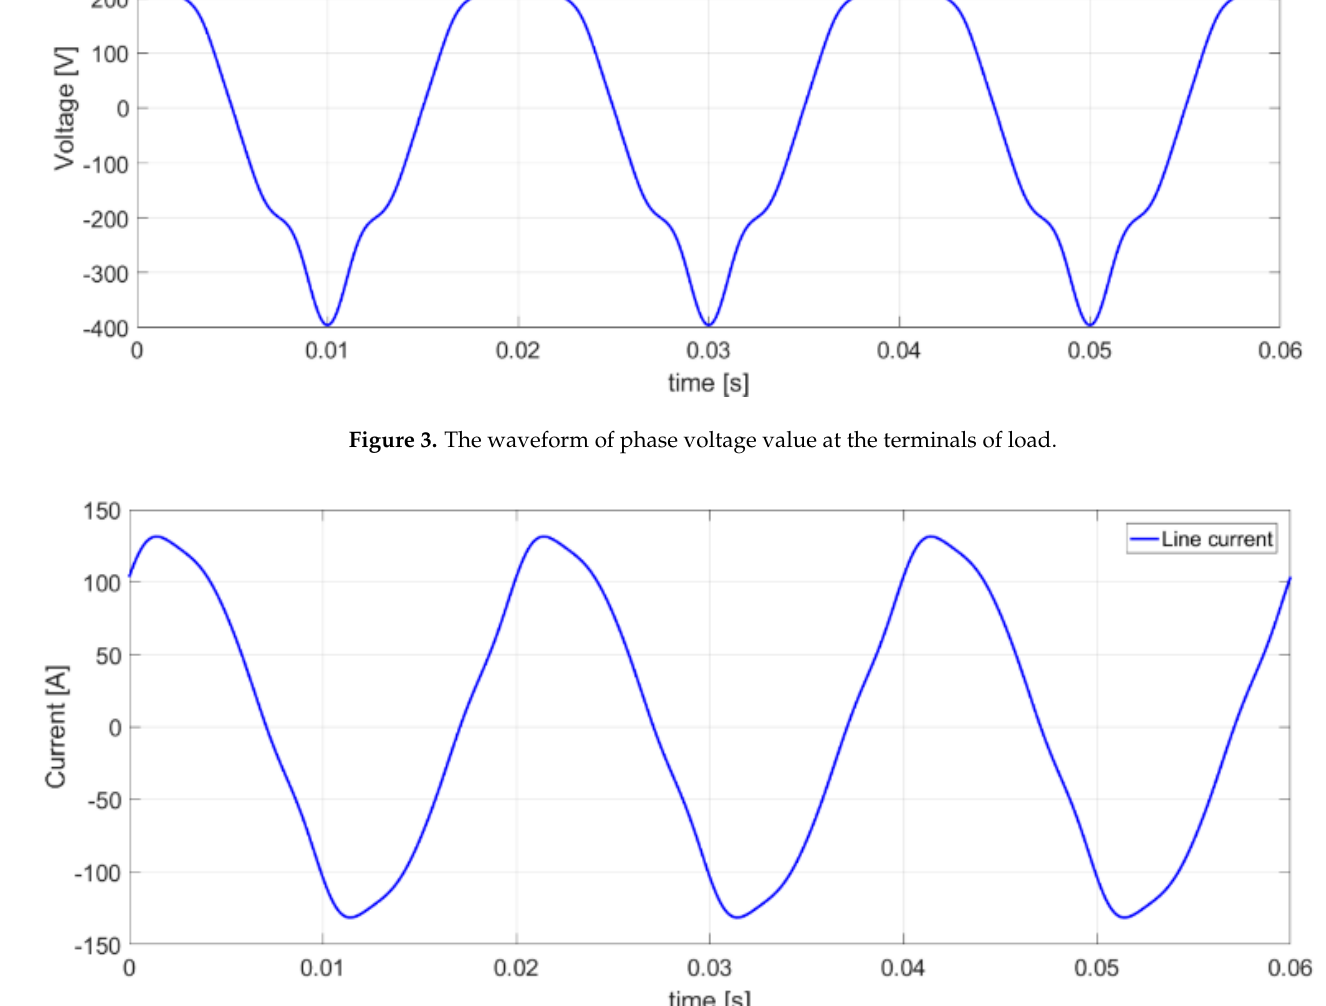
Figure 4. The waveform of the line current of the load.